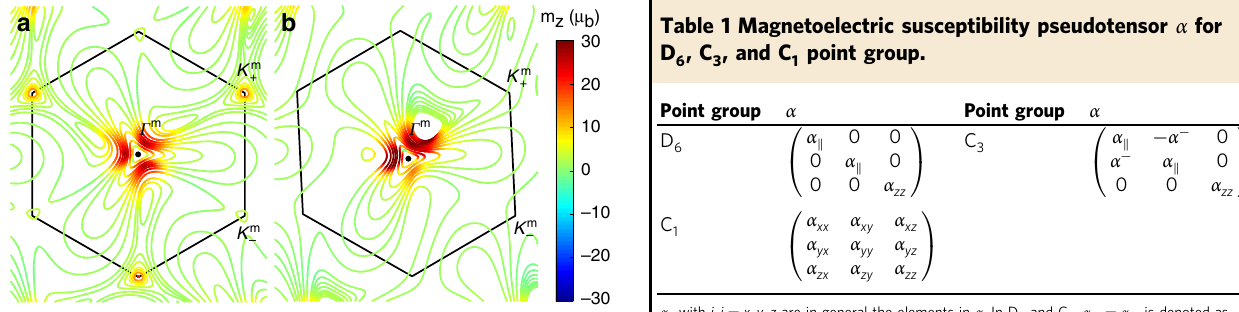
Fig. 2 The orbital magnetic moments of the Bloch electrons. a The orbital magnetic moments carried by the Bloch electrons in the mini-Brillouin zone with no strain. b The orbital magnetic moments of the electrons when a uniaxial strain characterized by ε ¼ 0 : 1 % is introduced. The staggered potential is set to be Δ ¼ 17 meV in both cases. In b , C 3 symmetry is broken and the Brillouin zone is deformed.